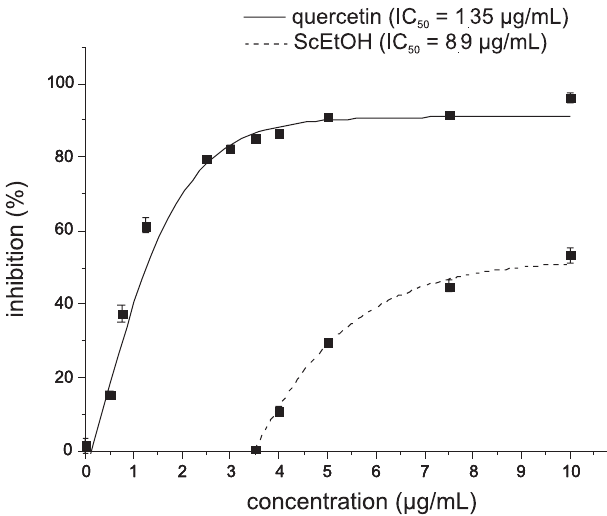
FIGURE 7 - Myeloperoxidase (75 mU) inhibition, by quercetin and ScEtOH, in a system with H (20 mM) The reactions were made in 50 mM sodium phosphate buffer, pH 7.0, 25 °C, and incubated by 60